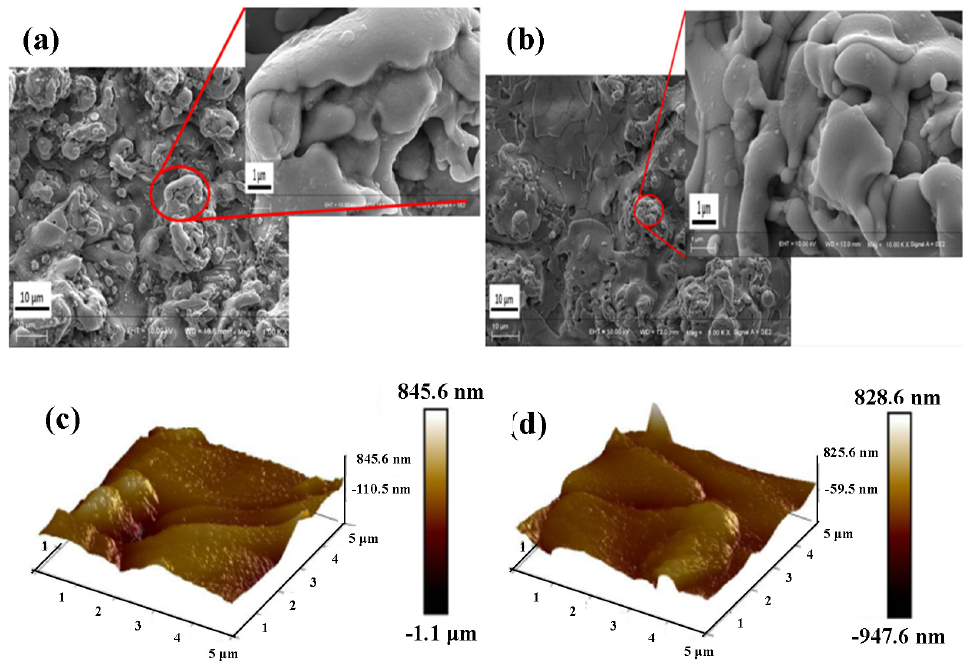
Figure 3. SEM spectrum before ( a ) and after ( b ) electrooxidation reaction. AFM before ( c ) and after electrooxidation ( d ) electrooxidation reaction.